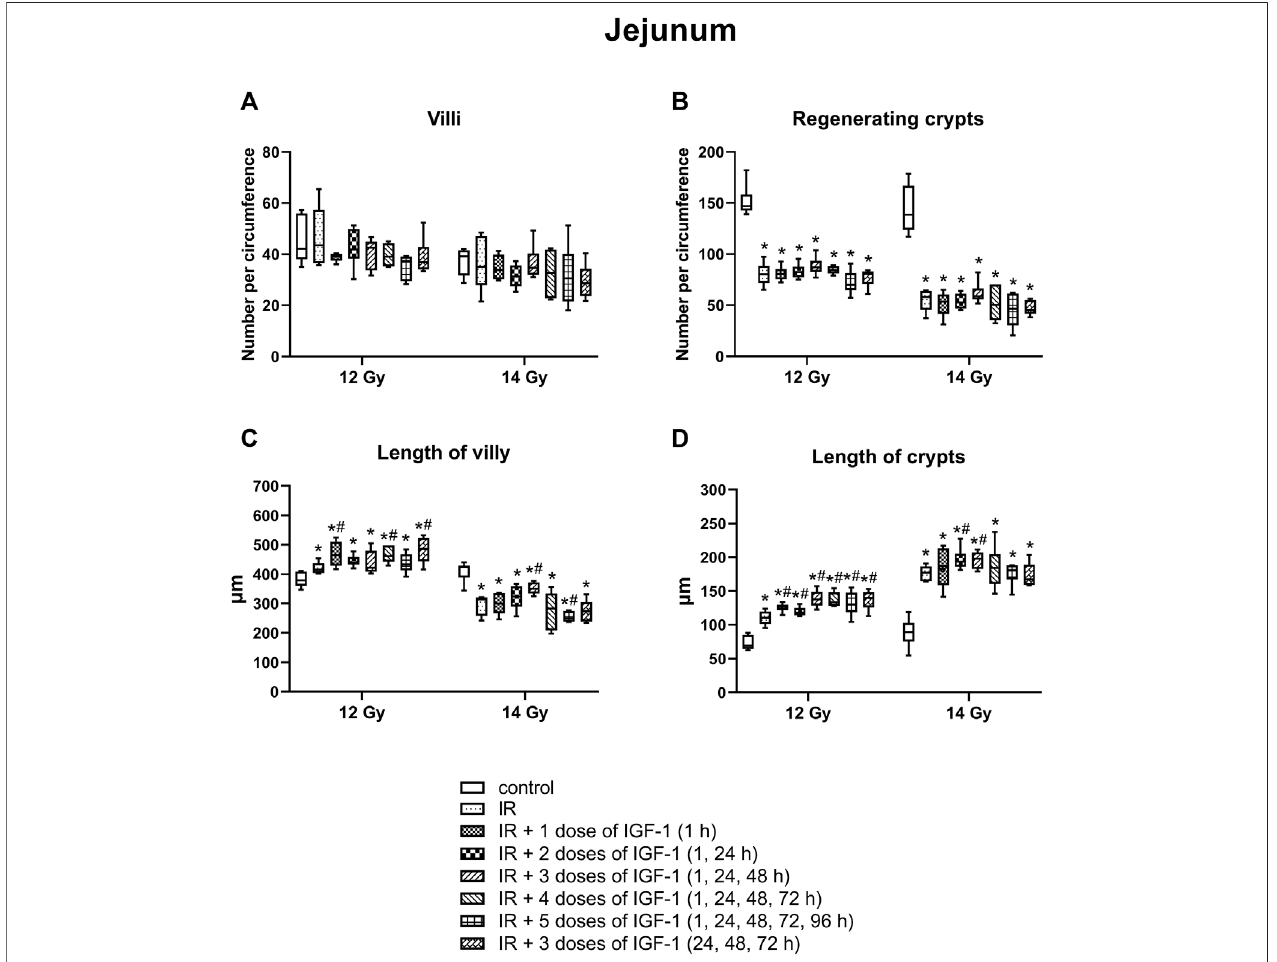
FIGURE6| EffectofdifferentIGF-1(1 mg/kg)therapeuticalregimensonjejunumofmiceirradiatedby12or14 Gywithshieldedheadandneck. (A) numberofvilly. (B) numberofsurvivingcrypts(microcolonyassay). (C) lengthofvilly. (D) lengthofcrypts.Signi fi cantlydifferentwhencomparedwiththenon-irradiatedcontrol:* p ≤ 0.05. Signi fi cantly different when compared with the solely irradiated group receiving no treatment: # p ≤ 0.05.